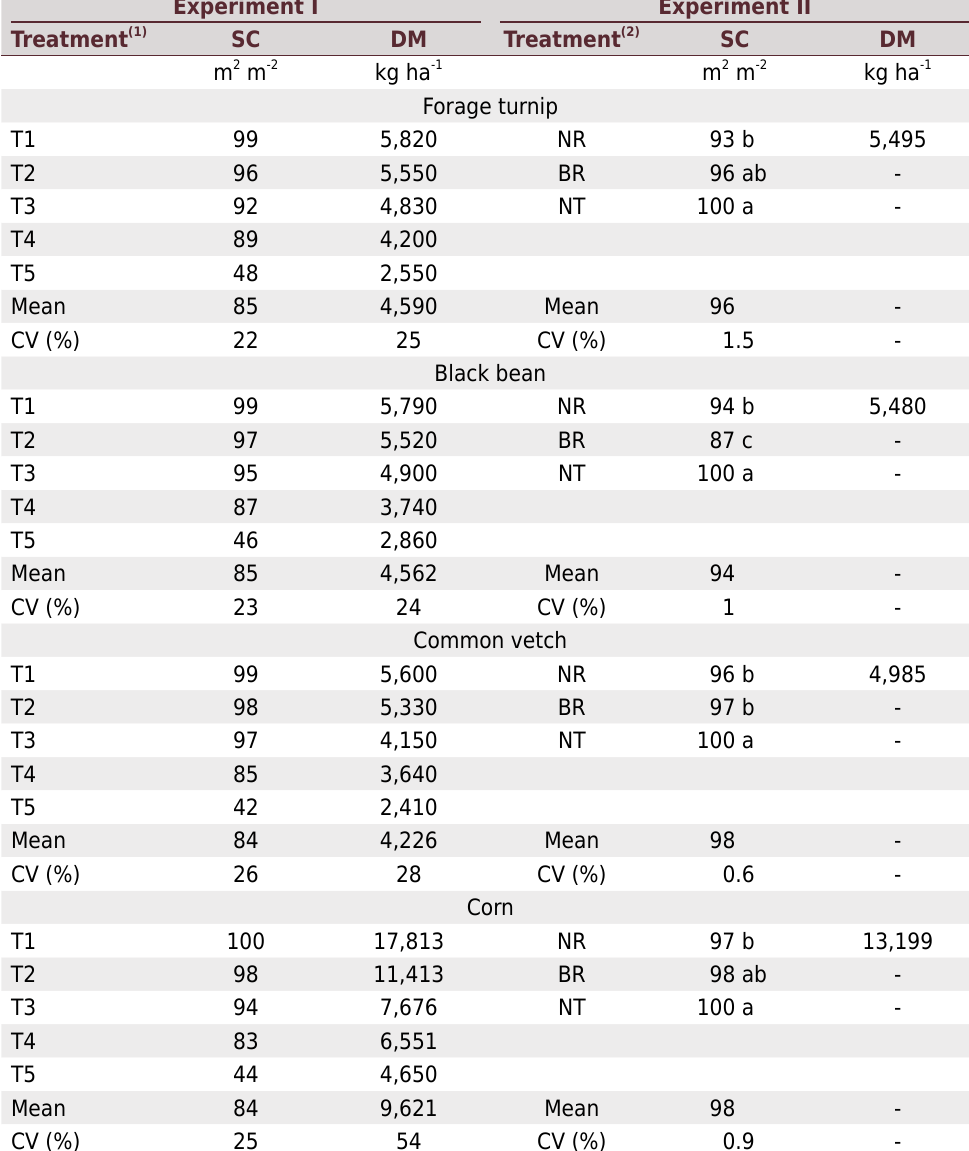
Experiment I Experiment II Treatment